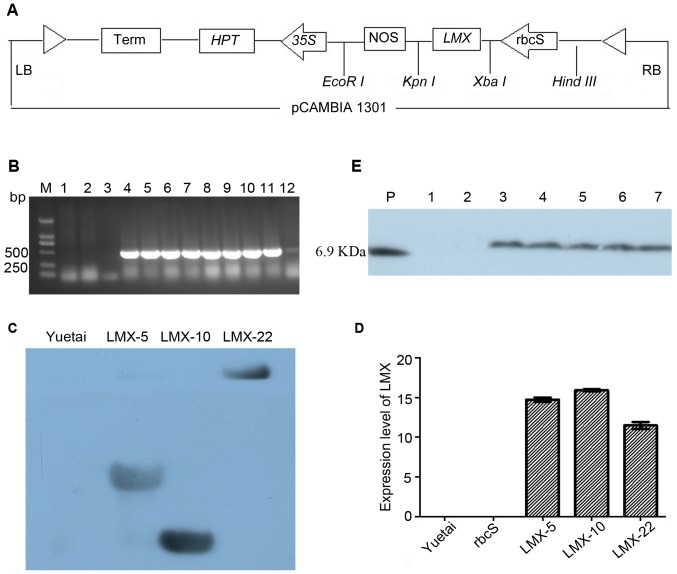
Molecular analysis of the LMX transgenic lines.
A. Schematic representation of the transgenic binary vector pCAMBIA 1301-LMX. B. Analysis of T0 independent transgenic plants expressing LMX by PCR. M, DL2000 marker; 1, Yuetai; 2, ddH2O; 3–12, T0 generation of transgenic plants expressing LMX gene. C. Southern-blot analysis of T0 transgenic lines with single copy insert. The DNA samples were hybridized with the prepared biotin-11-dUTP probe. D. qRT-PCR analysis of LMX expression in transgenic lines L-5, L-10, and L-22. The ubiquitin gene was used as the internal control. E. Western blot assay of T2 homozygous transgenic line L-10 using LMX antibody. P, purified LMX protein; 1, Yuetai; 2, empty vector transgenic line rbcS; 3–7, homozygous T2 LMX-10 transgenic lines.